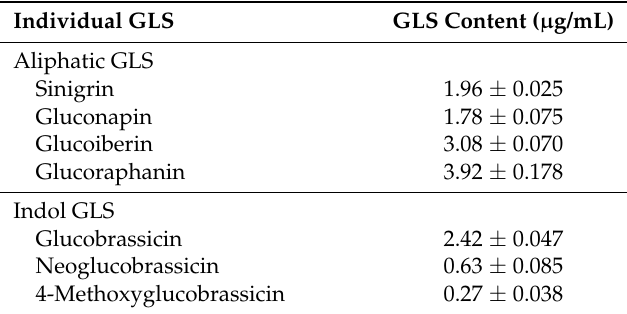
Table 2. Glucosinolates (GLS) content in York